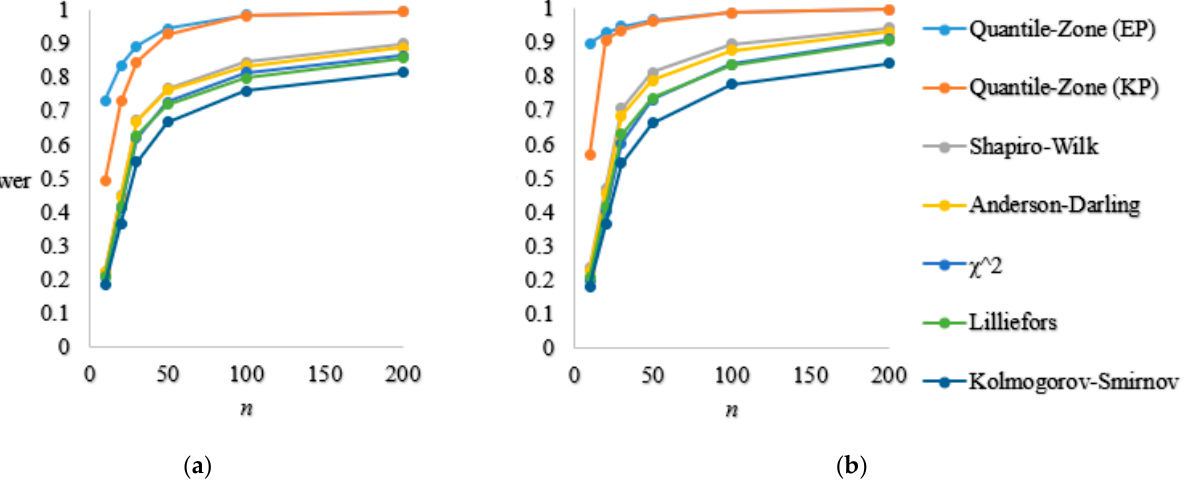
Figure 8. Average empirical power values of statistic V n and some other normality test statistics for various sample sizes with the level of significance α = 0.05: ( a ) Symmetric alternative distributions; ( b ) Asymmetric alternative distributions.